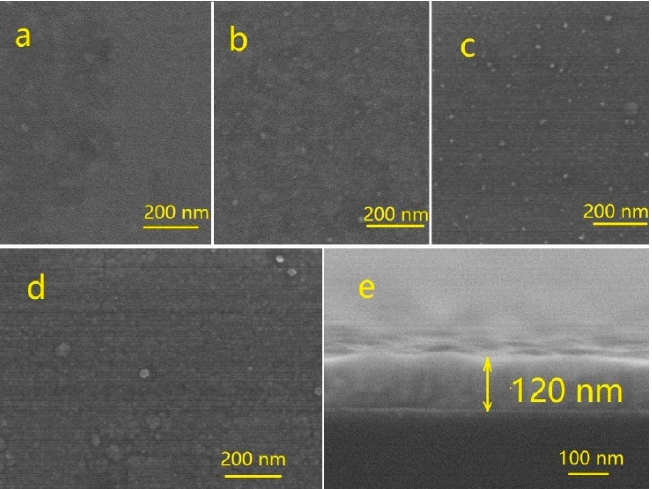
Figure 1. SEM surface morphology of Cu 3 N films prepared at different: ( a ) r = 1/6; ( b ) r = 1/3, ( c ) r = 1/2; ( d ) r = 1/1; ( e ) cross-sectional morphology of films prepared at r = 1/3.